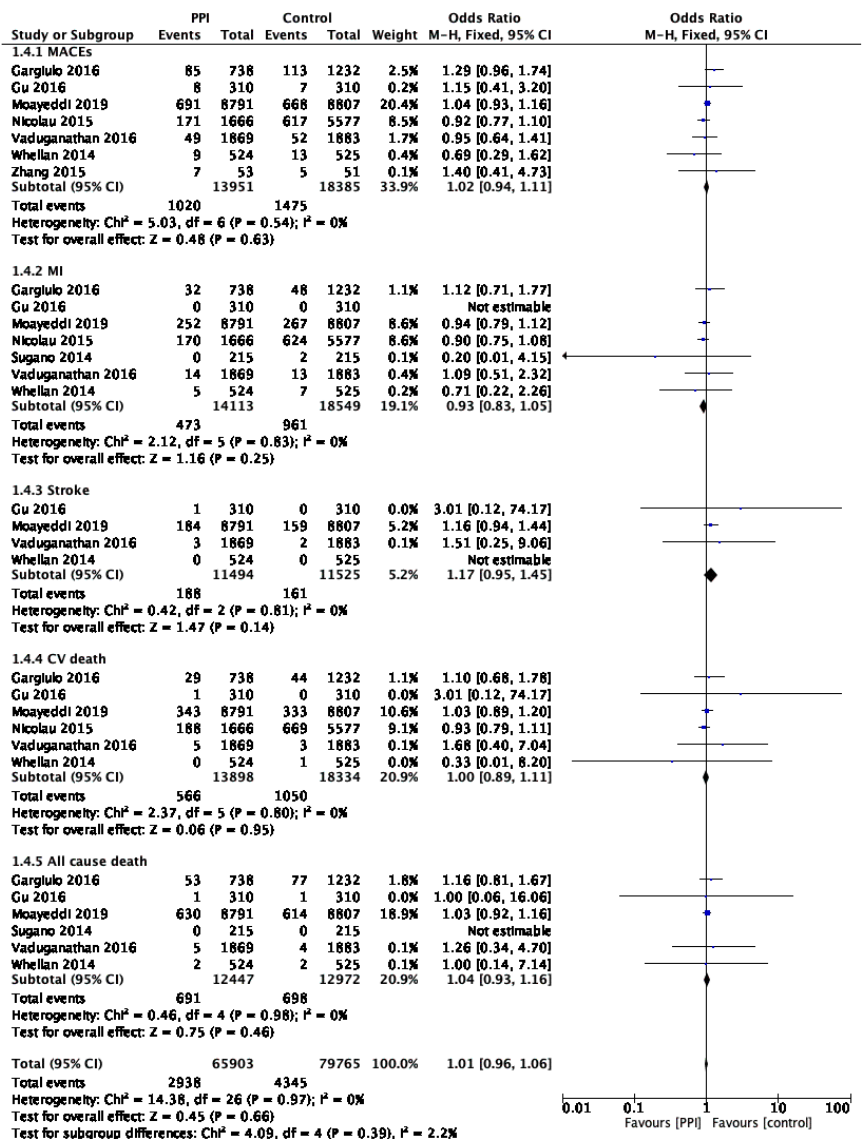
Figure 5. Forest plot illustrating the risk of cardiovascular events associated with the long-term PPI use within the RCTs using a fixed-effects model. Zhang 2015 [9]; Gu 2016 [14]; Nicolau 2015 [15]; Gargiulo 2016 [16]; Moayeddi 2019 [17]; Sugano 2014 [18]; Vaduganathan 2016 [19]; Whellan 2014 [23].